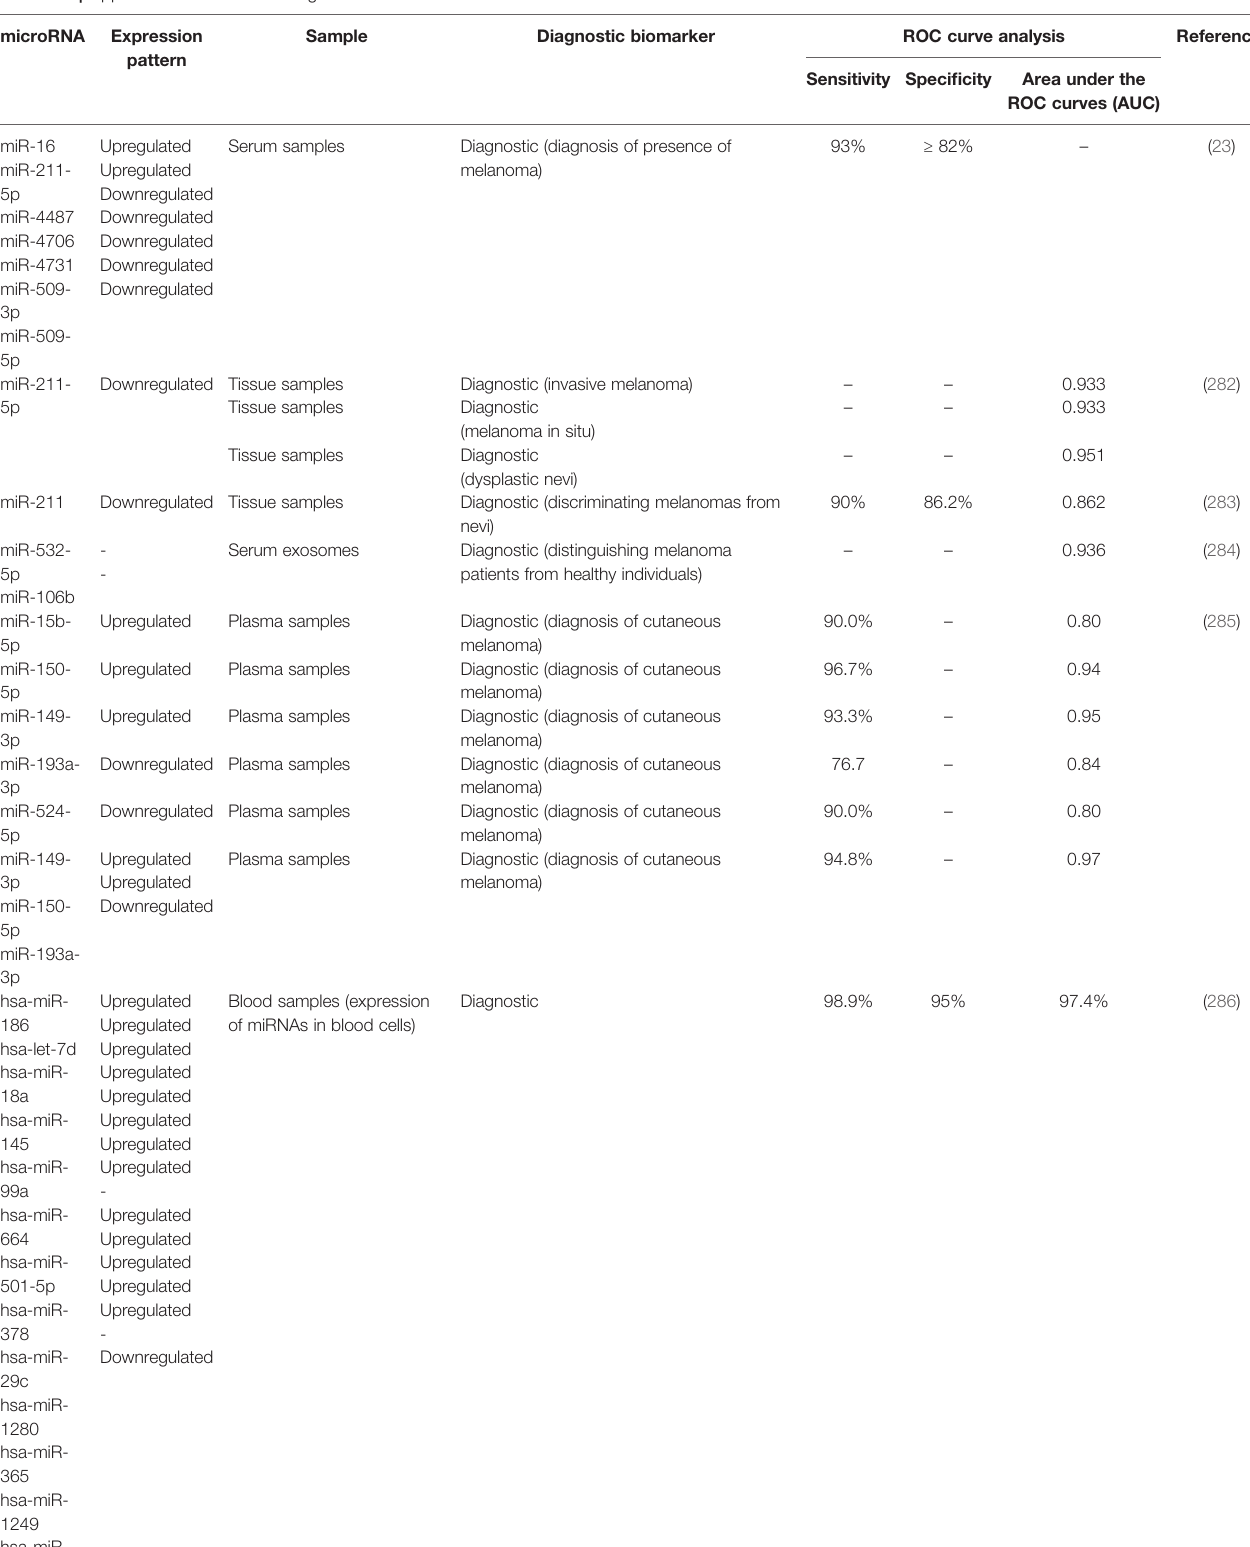
TABLE 4 | Application of miRNAs as diagnostic tools in